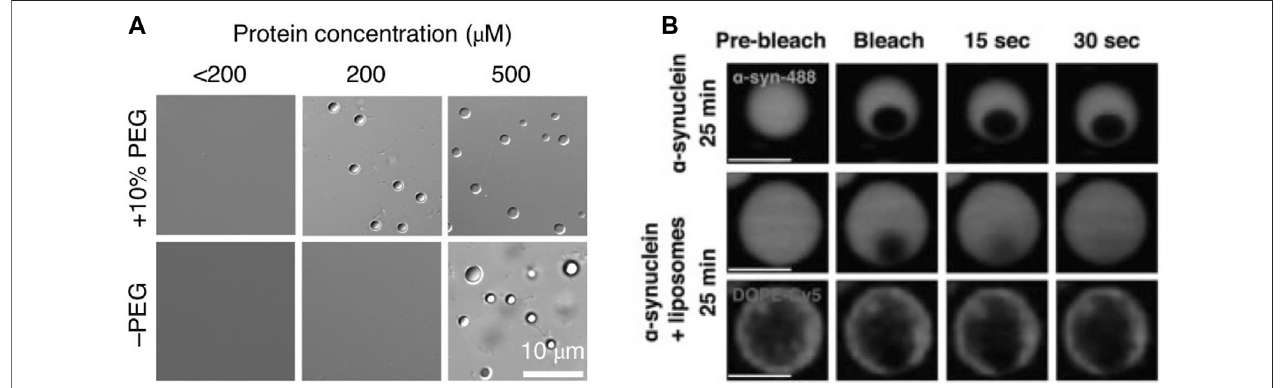
FIGURE3| α -synucleincanundergoliquid-to-solid transitionathighconcentrations invitro ,whichisreducedbynegativelychargedliposomes. (A) α -Synuclein( α - Syn) undergoes LLPS in vitro . Differential interference contrast (DIC) images of α -Syn phase-separated droplets at different protein concentrations in the presence and absence of the molecular crowder PEG-8,000. From (Ray et al., 2020). (B) α -synuclein/liposome droplets mature slower than droplets containing α -synuclein only (protein:lipid, 1:1). Lowering the protein:lipid ratio to 10:1 results in a loss of the protective effect. From (Hardenberg et al.,